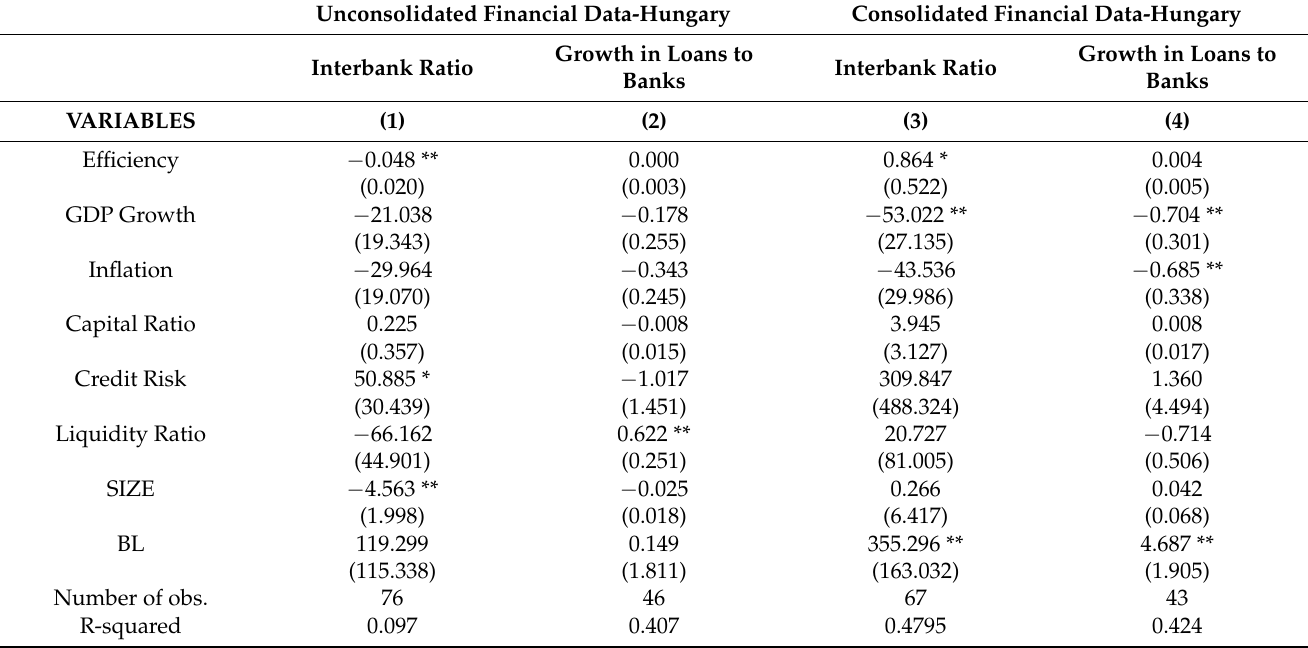
Table 9. Do banks shift their activities into countries with lower tax rate? Symbols *, and ** represent statistical significance at the levels of 10%, and 5%,